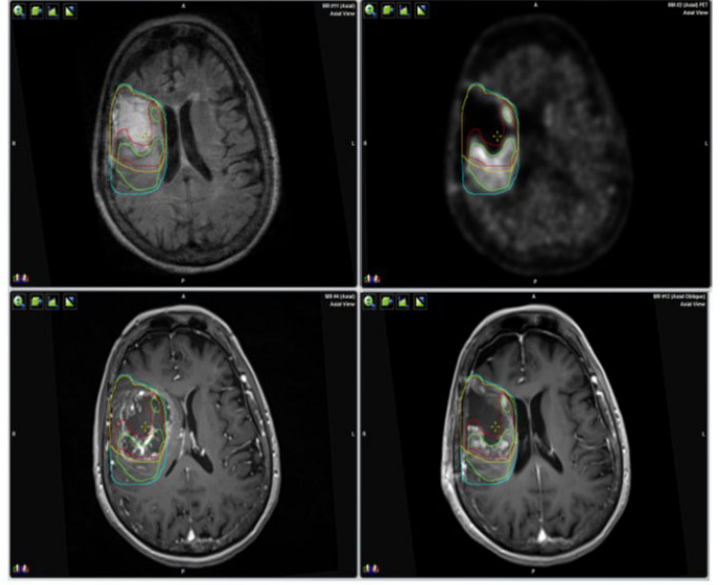
Figure 1. Volumes definition on post-contrast MRI, FLAIR, MRI and 11CMETPET. Clinical target volume 1 (CTV1)—yellow line; clinical target volume 2 (CTV2)—light blue; contrast ‐ enhanced residual tumor volume (CERTV)—red; 11METPET uptake—green.